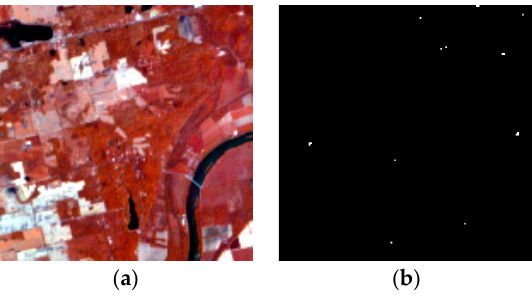
Figure 13. Hyperion data set: ( a ) RGB composite (36, 23, 12); and ( b ) ground-truth.